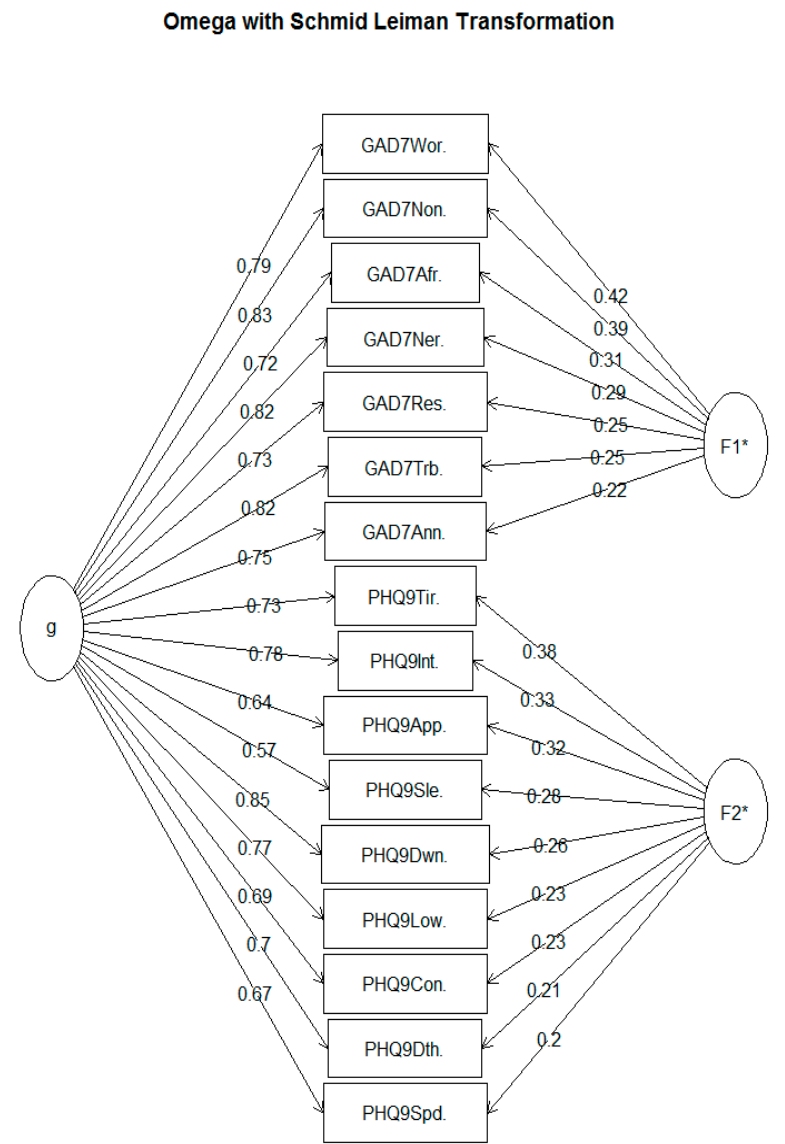
Figure A2. The bifactorial model for Patient Health Questionnaire for depression (PHQ-9) and seven-item scale for Generalised Anxiety Disorder (GAD-7).